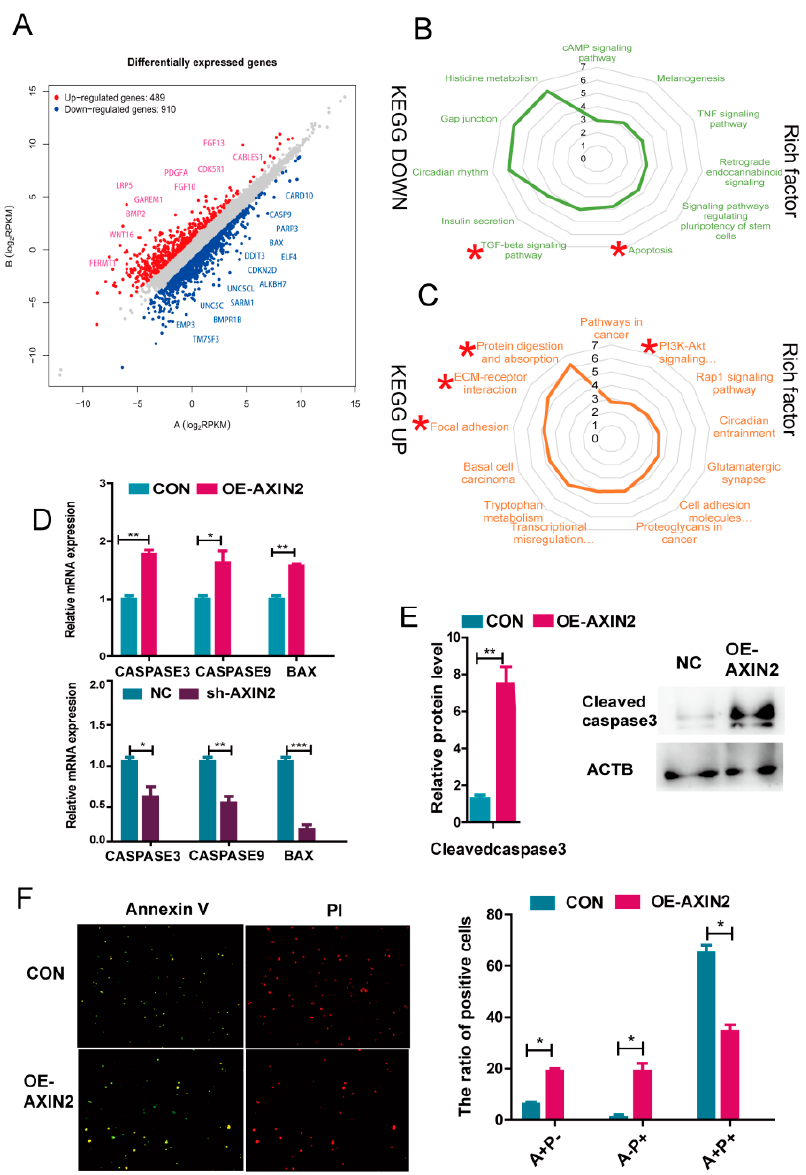
Figure 5. AXIN2 affects the survival of piPSCs through the caspase family. ( A ) Transcriptional changes of the NC and sh-AXIN2 piPSC groups; ( B ) KEGG enrichment of down-differentially expressed genes in sh-AXIN2 cell lines; ( C ) KEGG enrichment of up-differentially expressed genes in sh-AXIN2 cell lines; ( D ) qPCR analysis of CASPASE3 , CASPASE 9 , and BAX in NC, sh-AXIN2, and CON, OE-AXIN2 groups; * represents p < 0.05, ** represents p < 0.001, and *** represents p < 0.0001; ( E ) western blot analysis of Cleaved caspase3 in the NC and OE-AXIN2 groups; ( F ) representative images of piPSCs stained with PI (P) and Annexin V (A) after 5 d of culture in the Left; NC and OE-AXIN2 groups. A+/P+: non-viable apoptotic cell or necrotic cells; A − /P+: mechanic injury; A+/P − : viable apoptotic cell. The quantitative analysis is shown on the right. n = 3 independent experiments. The scale bar represents 400 µ m; Right, Ratio of positive cell of PI (P) and Annexin V (A) staining; * represents p < 0.05.